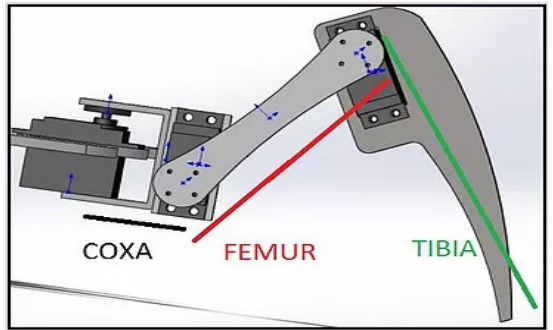
Fig. 4. Front view showing one leg of the quadruped and its links (Coxa, Femur, Tibia) [15]